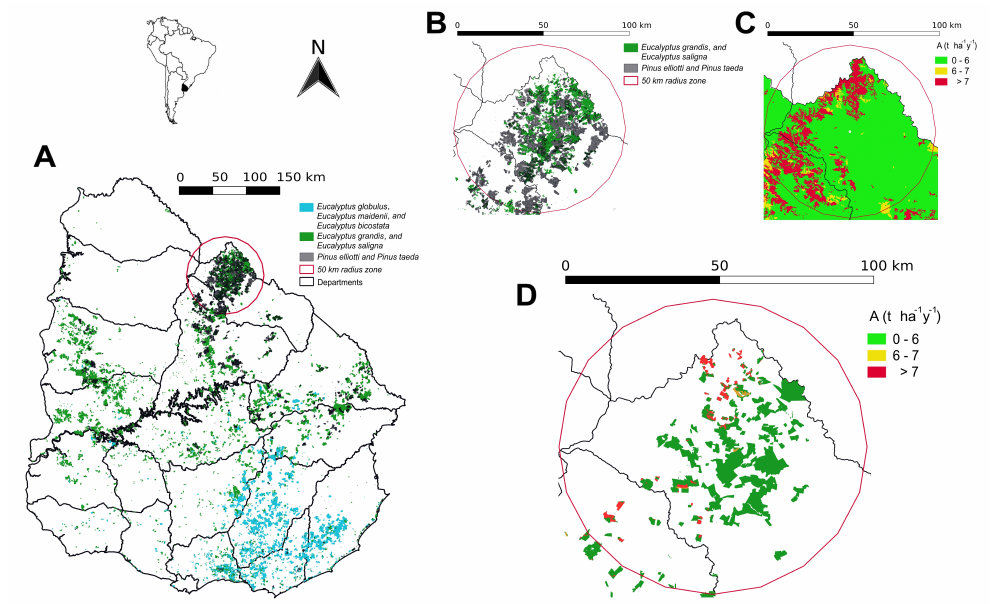
Figure 7. ( A ) Current forest plantations reported by forest statistics 2019, ( B ) forest plantations in a 50 km radius zone, ( C ) soil erosion by water estimated by Carrasco-Letelier and Beretta-Blanco [18] and ( D ) soil erosion in plantations considered by this study.